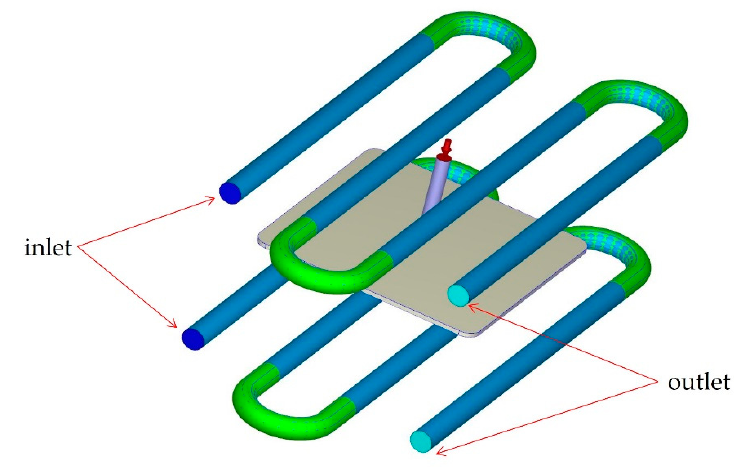
Figure 3. The cooling channels.